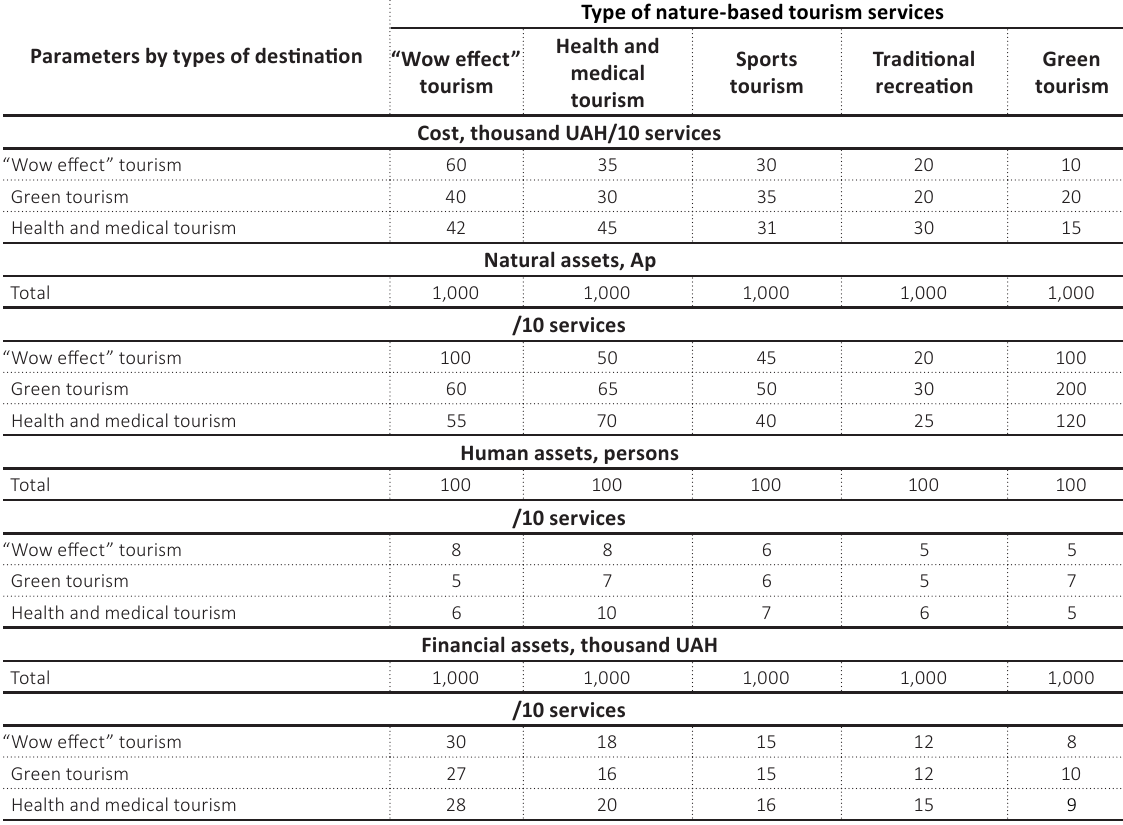
Table A1. Input data for the model of change management in the field of nature-based tourism in Ukraine (conditional example)